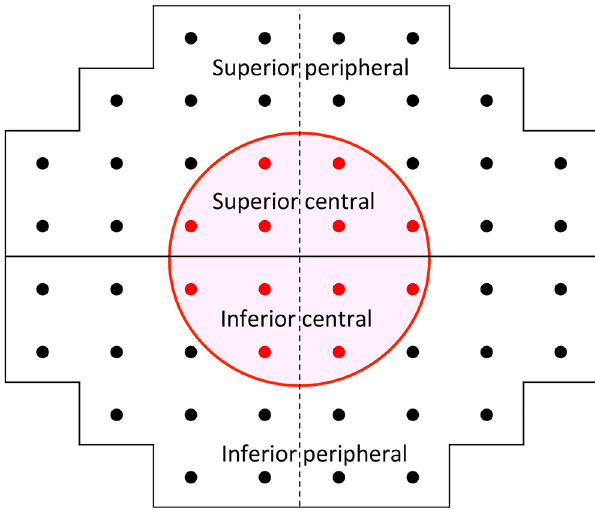
Fig 1. Mapping of the superior peripheral, superior central, inferior central and inferior peripheral areas. VF was divided outside and within central ten degrees. These areas also follow mapping in the 24 – 2 and 10 – 2 visual fields of the Humphrey Field